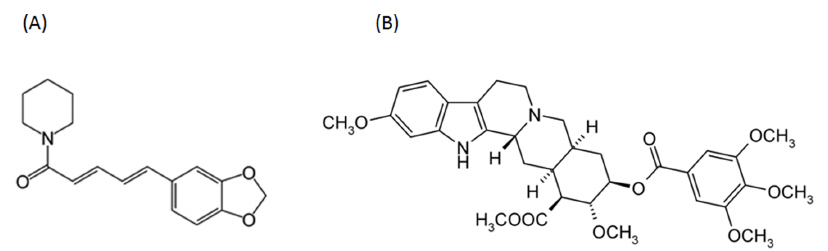
Figure 1. Molecular structure of alkaloids used in this study. (A) piperine, molecular weight: 285.34 and (B) reserpine, molecular weight: 608.68.